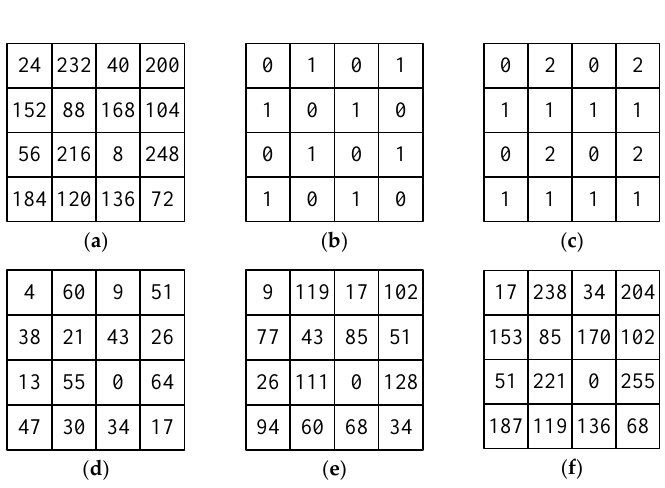
Figure 4. Examples of ( a ) ODBTC dither array, 𝐷(𝑥,𝑦) and its scaled version (stored as LUT for